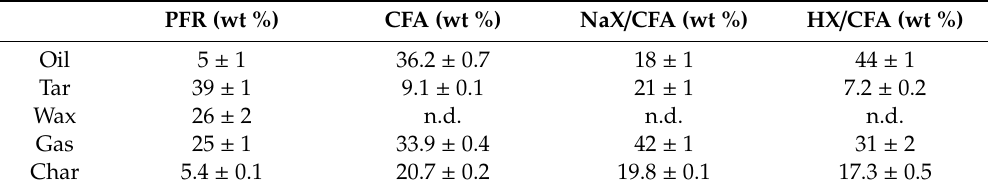
Table 2. Comparison of products yields by thermal and catalytic pyrolysis of PFR at 723